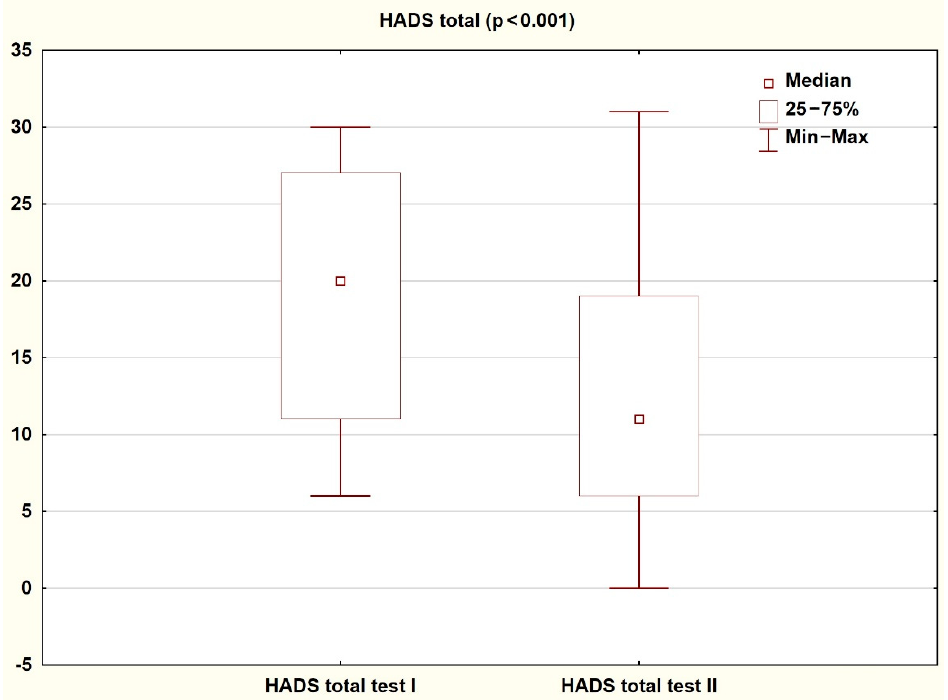
Figure 3. Patient results in the HADS-A subscale during the first and second study (Wilcoxon test).